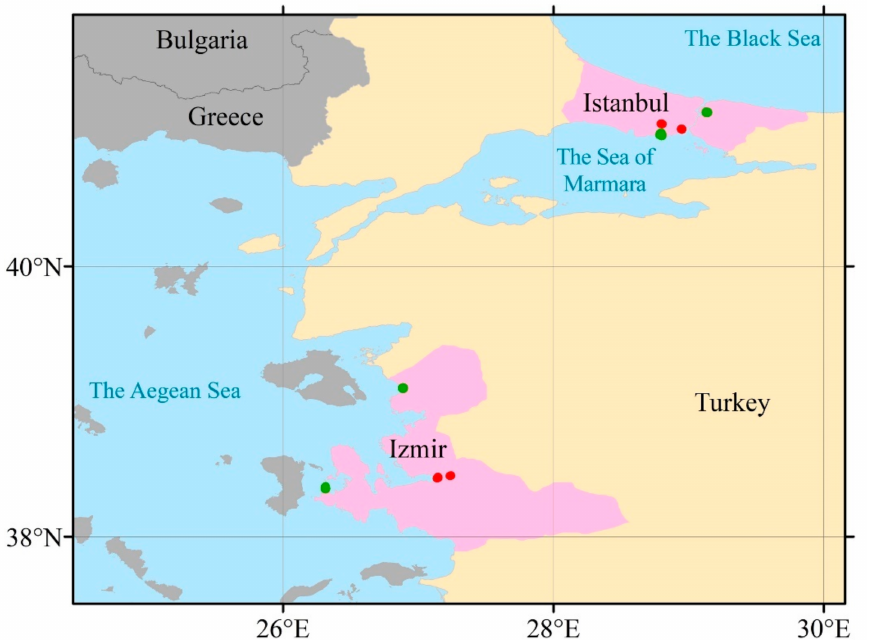
Figure 1. Location of attached (red points) and detached (green points) building groups in Istanbul and Izmir (map data taken from the Global Administrative Areas [31]